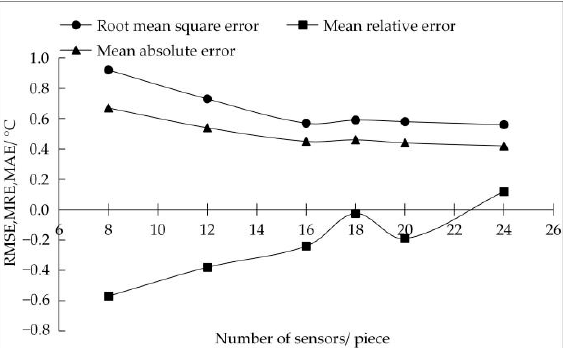
Figure 8. ▲ is the average of the mean absolute error after reducing the same number of sensors in different ways, ▄ is the average of the mean relative error, and ● is the average of the root mean square error.